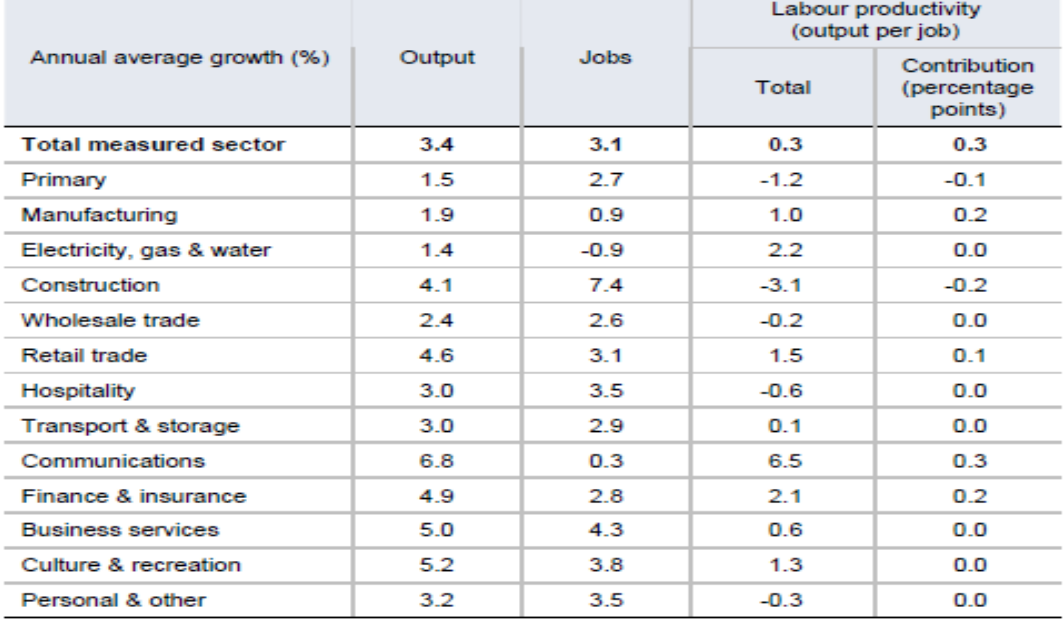
Table 3 Output, Jobs, Labour Productivity and Contribution to Labour Productivity Growth by Industry (seven years to March